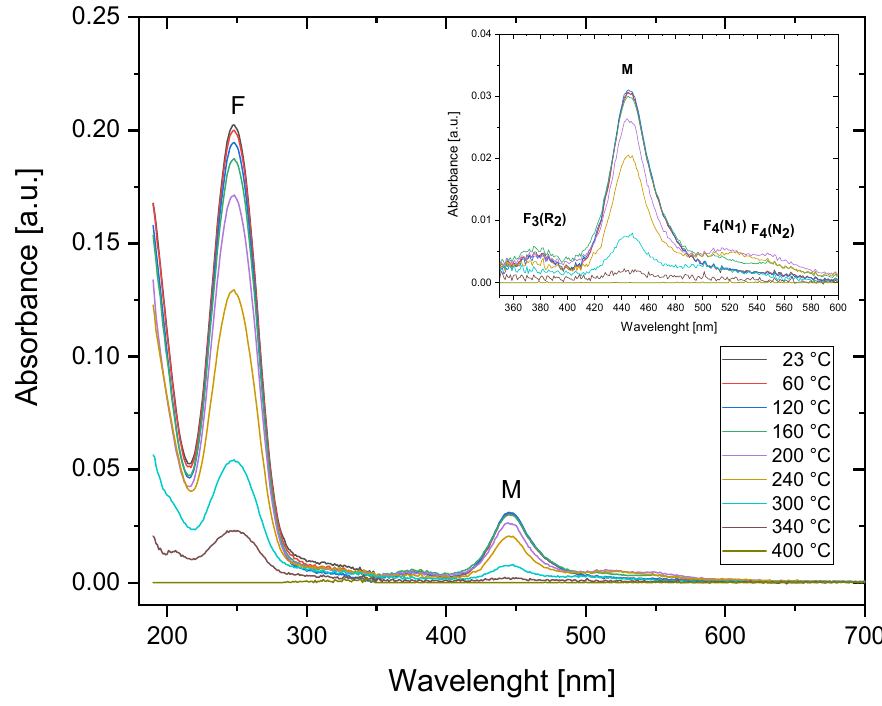
Figure 3. Absorption spectra for the sample irradiated with Am-241 alpha particles (fluence 3.4 × 10 12 cm − 2 ) and submitted to a series of subsequent heat treatments at increasing temperatures (Method 1). Measurements were obtained at room temperature.